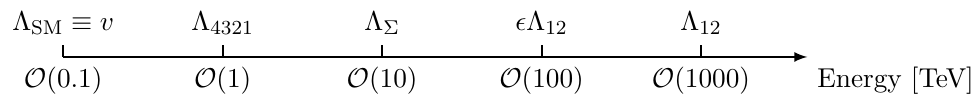
Figure 6 . The relevant energy scales in our model, which are associated with different symmetry breaking steps (as detailed in figure 1), are each separated by roughly an order of